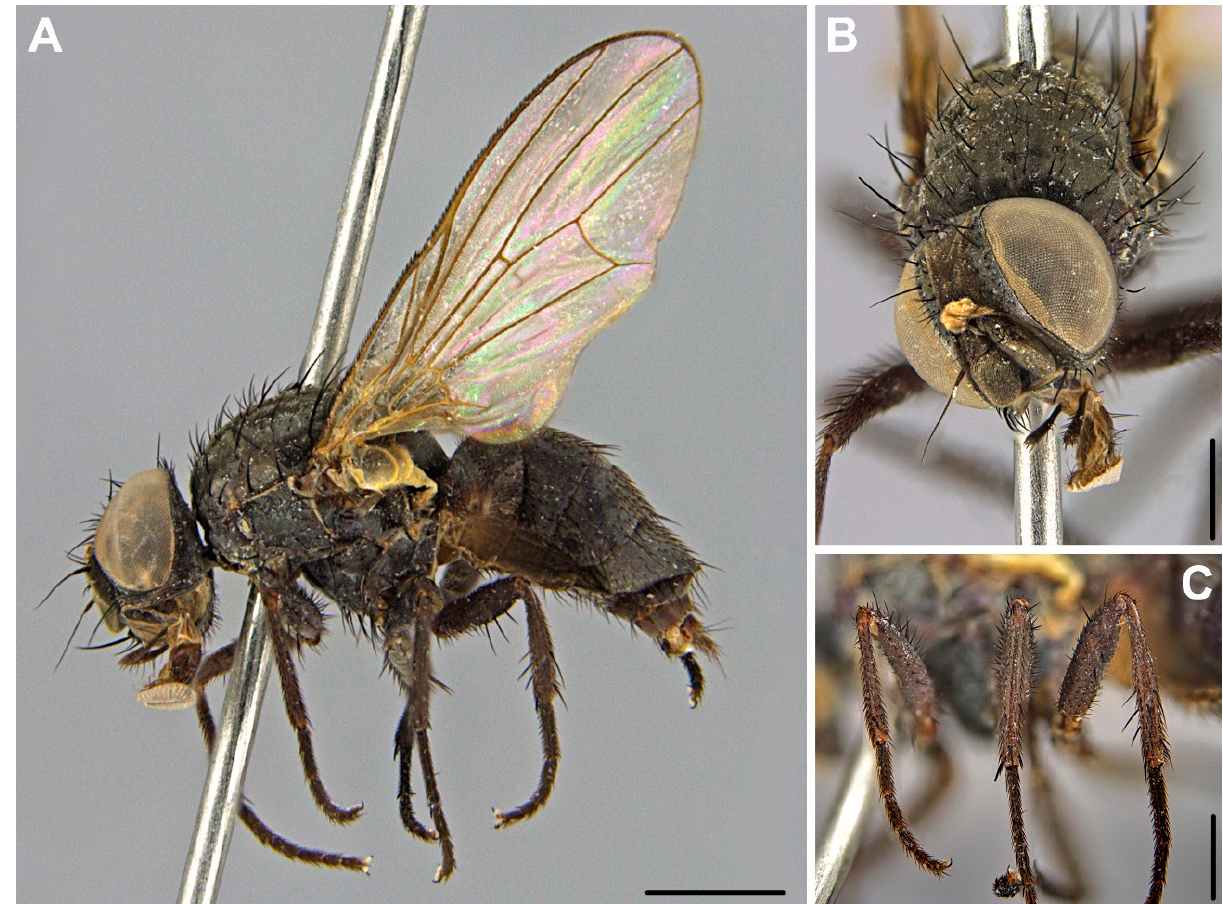
Figure 5. Female of Fannia collini : ( A ) lateral view; ( B ) head in anterior view; ( C ) legs in dorsal aspect. Scale bar 1 mm ( A ) and 500 µm ( B , C ).